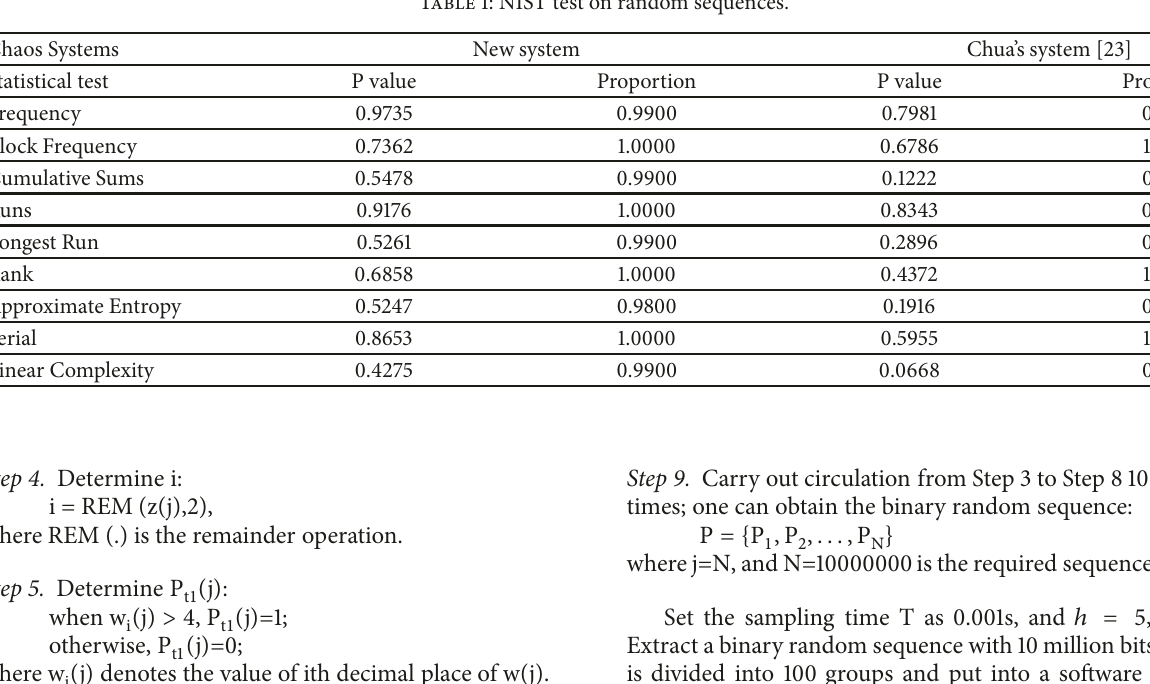
Table 1: NIST test on random